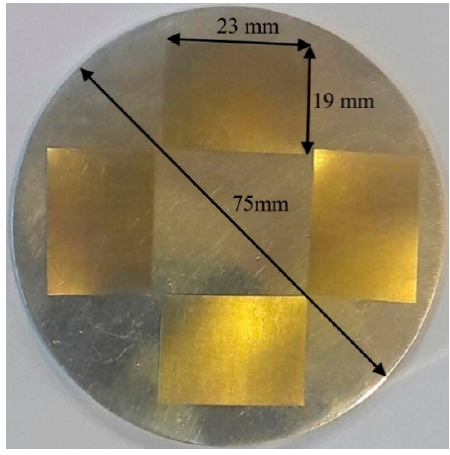
Figure 2. The compound target of Ag–Au.